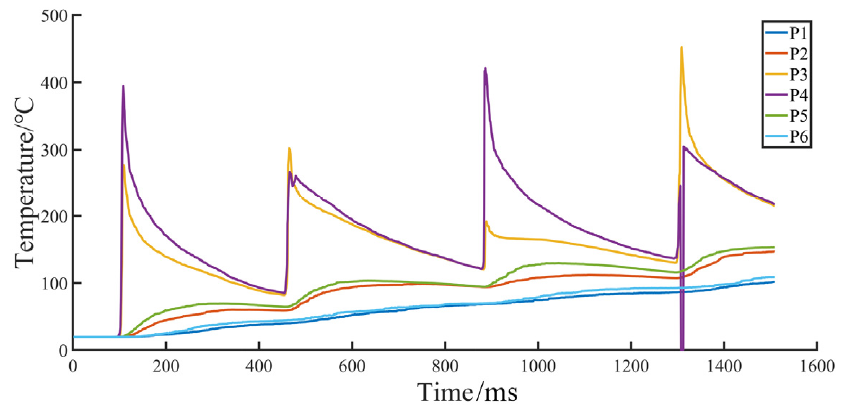
Figure 19. Temperature change at each point in the simulation process.